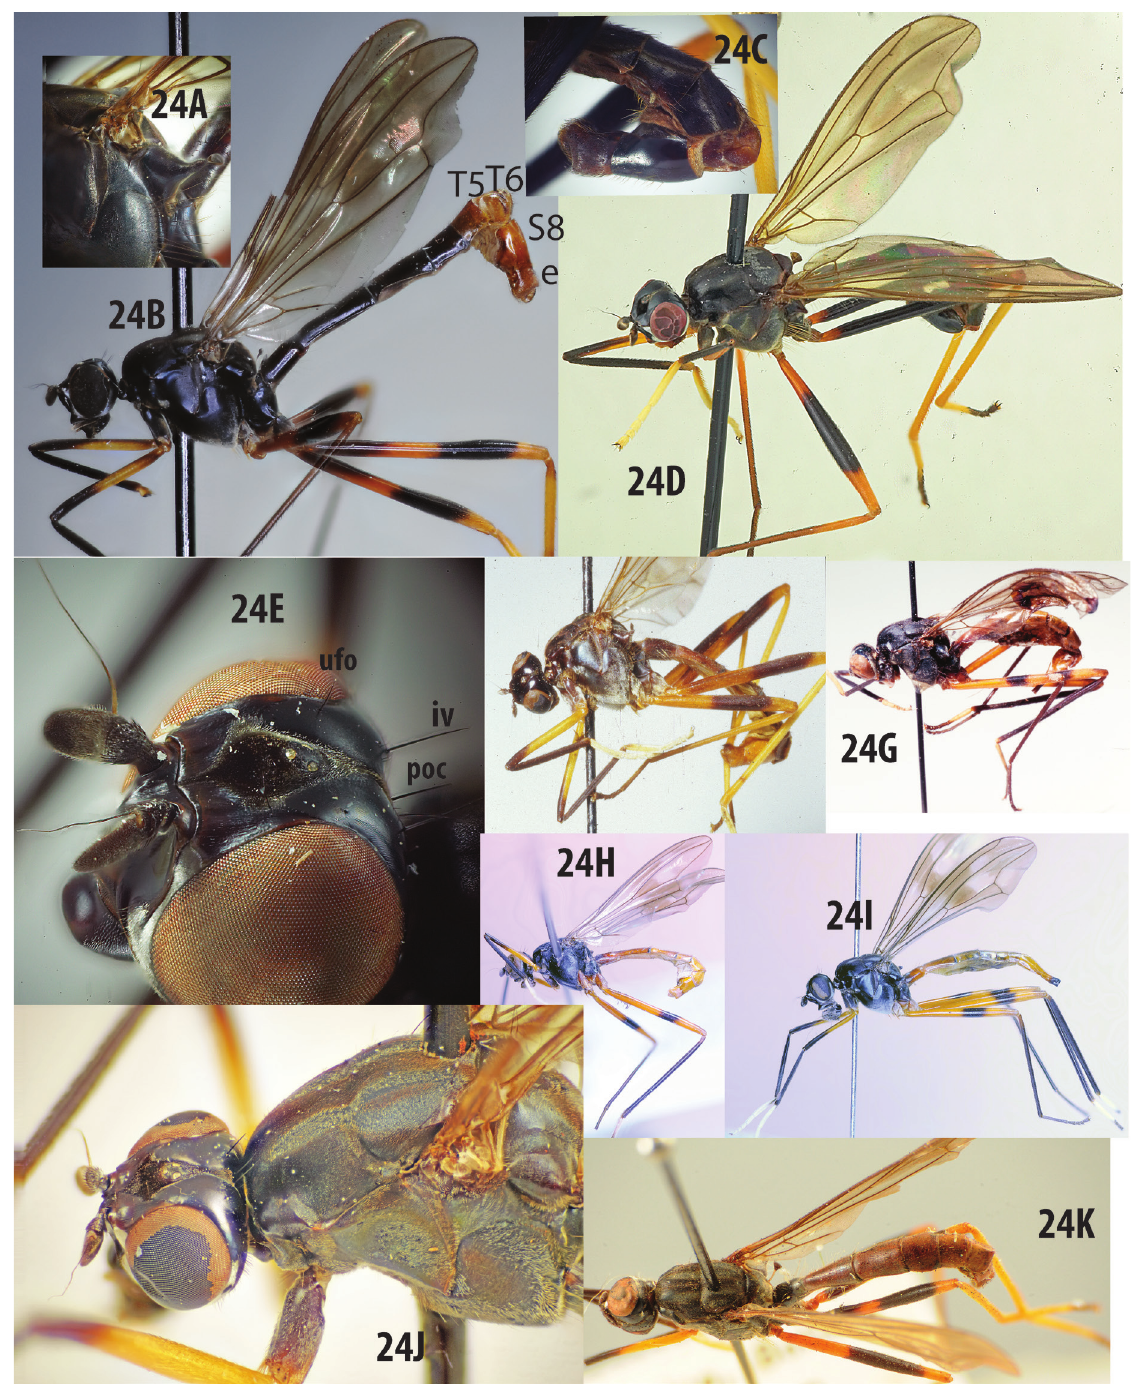
Fig. 24. Mesoconius infestus Enderlein, 1922 (species complex), external characters and colour variation . A . Thorax and base of abdomen, ♂, showing prominent katatergite. B . ♂, DEBU, Baeza, Ecuador. C–D . ♂, DEBU, SierrAzul Lodge, Eucador. E . Head, specimen from SierrAzul. F . Lectotype, ♂ , MNBG, Piñipiñi Valley, Peru. G . Holotype of M. enderleini Frey, 1927 (junior synonym of M. infestus ), ♀ , ZMUH, Colombia. H . ♂, specimen from Colombia. I . ♀, specimen from Colombia. J . Head and thorax, specimen from Bolivia. K . Habitus, ♀, BMNH, oviscape removed, specimen from Bolivia. Abbreviations: e = epandrium; iv = inner vertical bristle; poc = postocellar bristle; ufo = upper